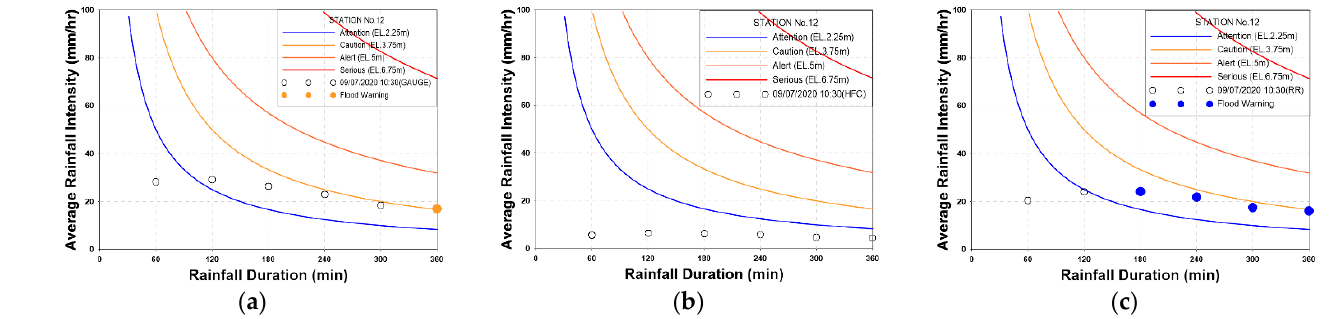
Figure 12. Calculation results of the flood forecast information for 7 September 2020, at 10:30: ( a ) Ground rain gauge; ( b ) CMP_HFC; ( c ) SAM_RR.